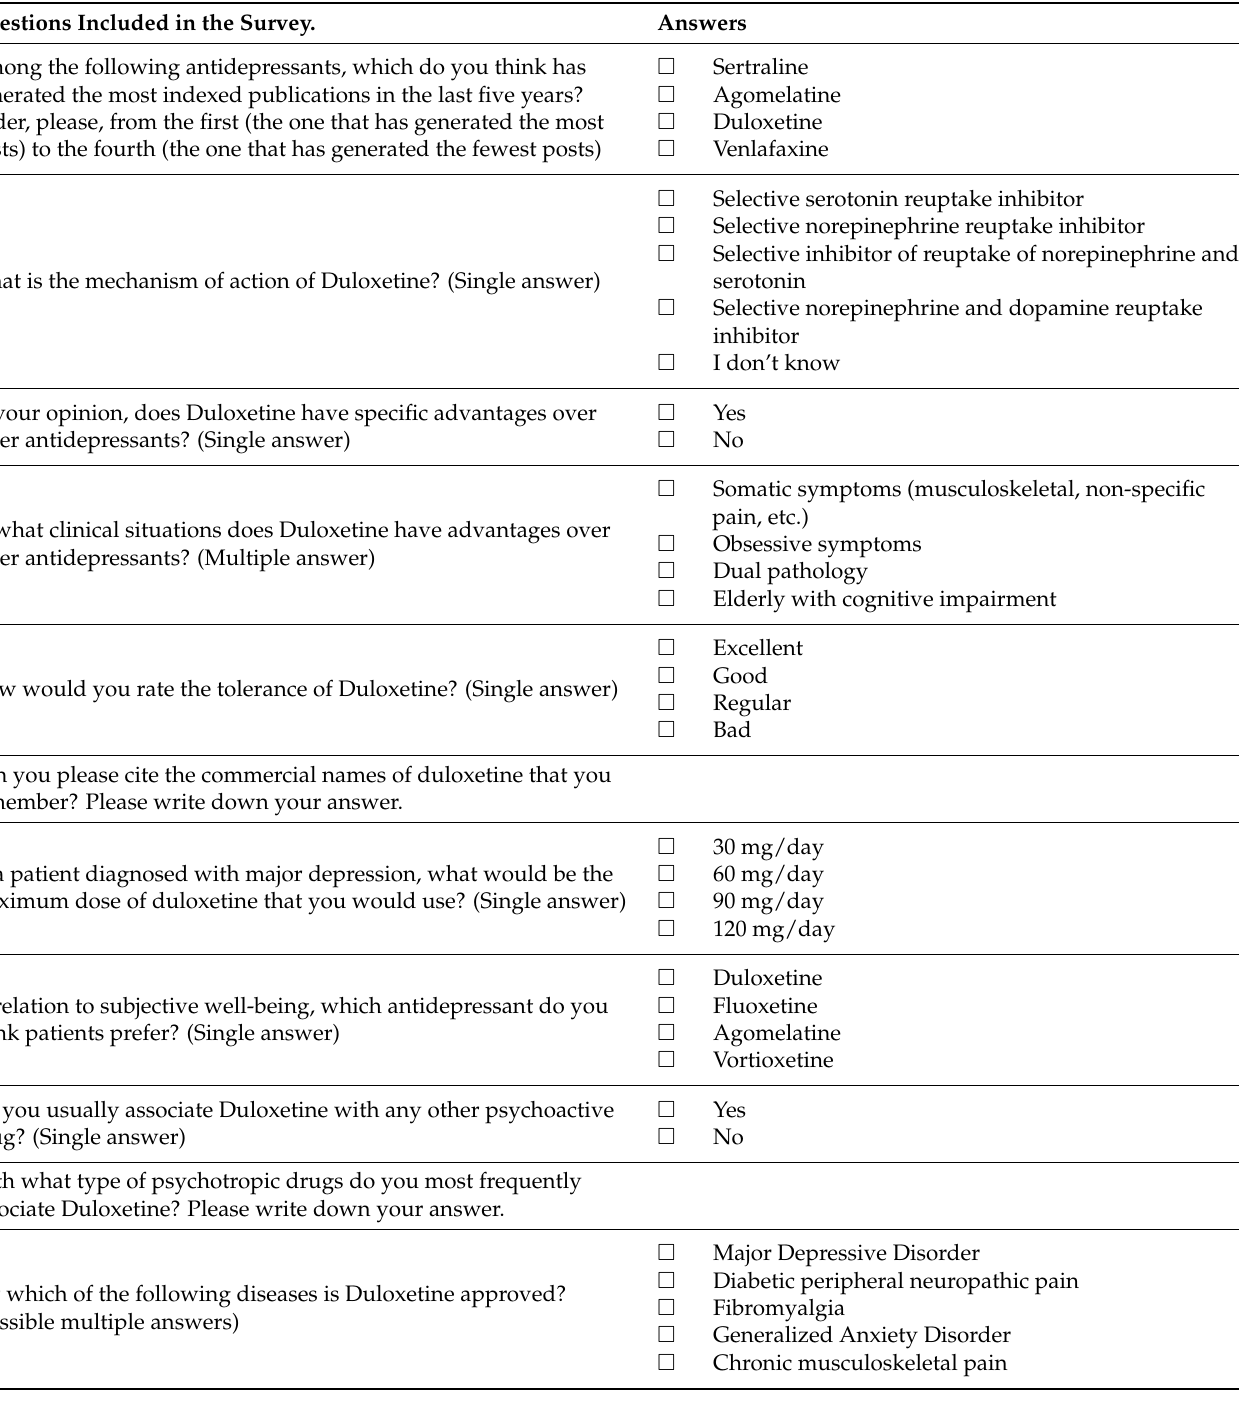
Table 1. Questions included in the